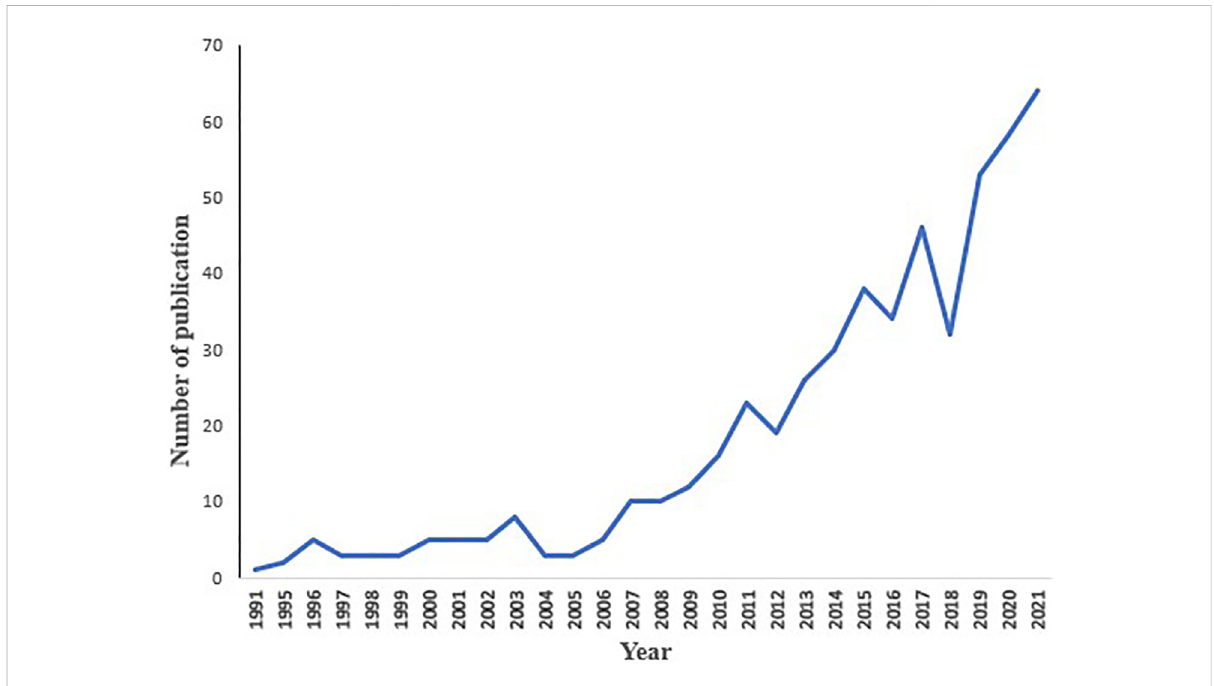
FIGURE 2 Trends in the RDP publication from 1991 to